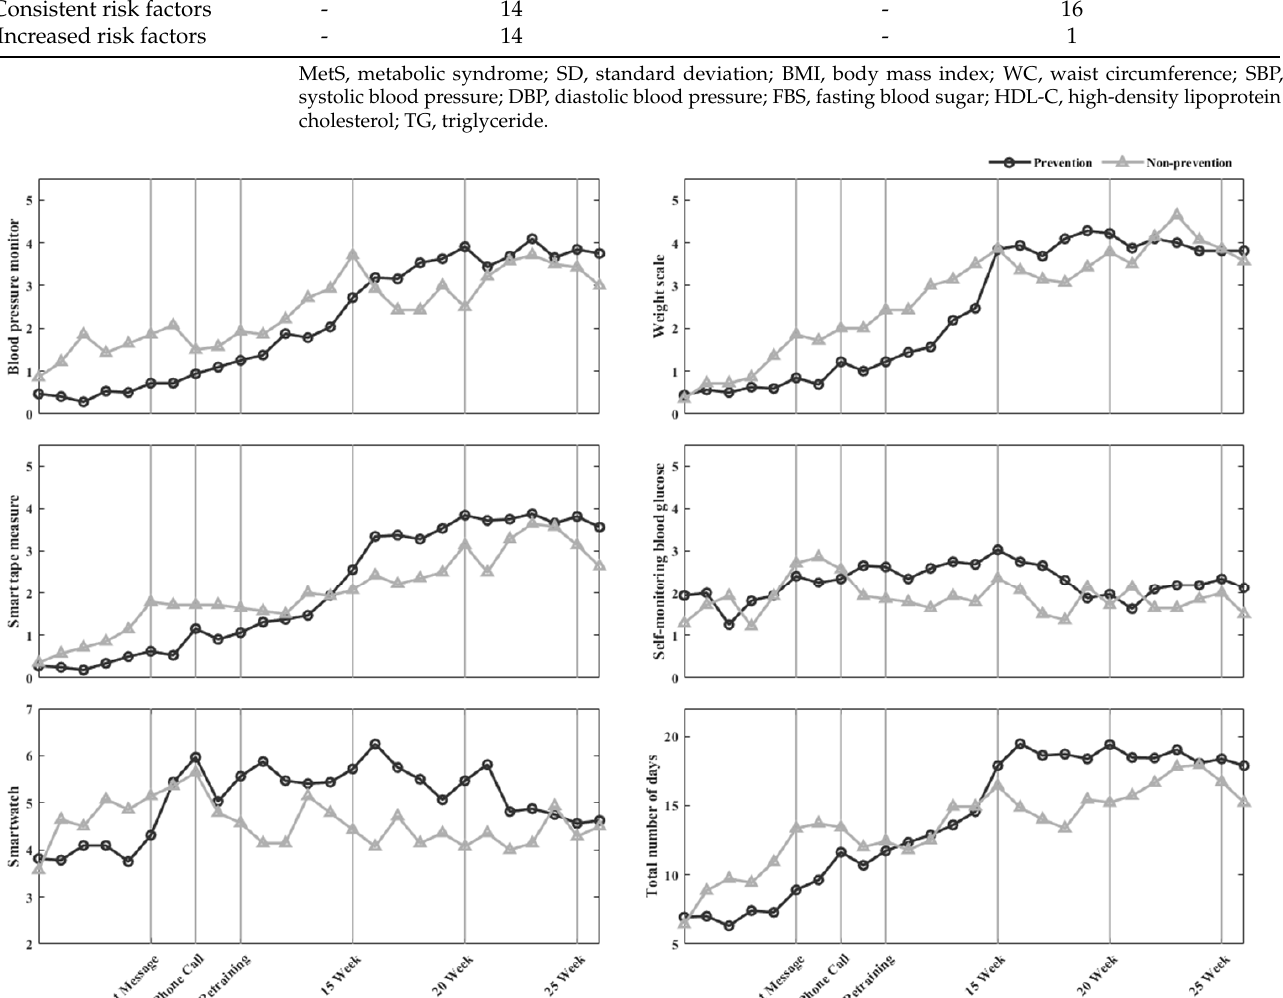
Figure 3. In MetS, the number of days healthcare devices were used per week. 3.3. Characteristic of Self-Care Using Healthcare Devices 3.3.1. The Frequency of Healthcare Device Use The frequencies of healthcare device use are presented in Table 2. For those with pre- MetS, there were significant differences in the use of a smart tape measure, SMBG, smart- watch, and total number of use days between the prevention and non-prevention groups ( p < 0.05). For those with the MetS, there were significant differences between the improve- ment and non-improvement group ( p < 0.05) in the use of the five healthcare devices and the total number of use days.